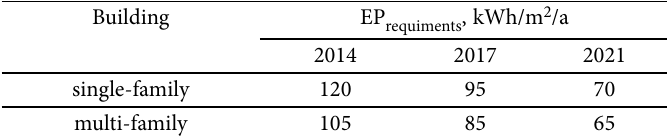
Table 1. Energy requirements for buildings (Polish law: Dz. U., 926, 2013)